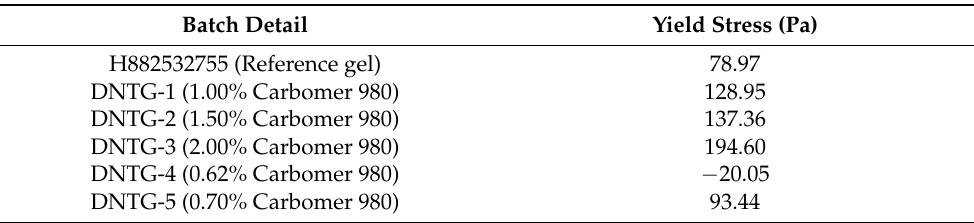
Table 2. Yield stress data for reference gel and niosomal gel formulations containing different concentrations of Carbomer 980.